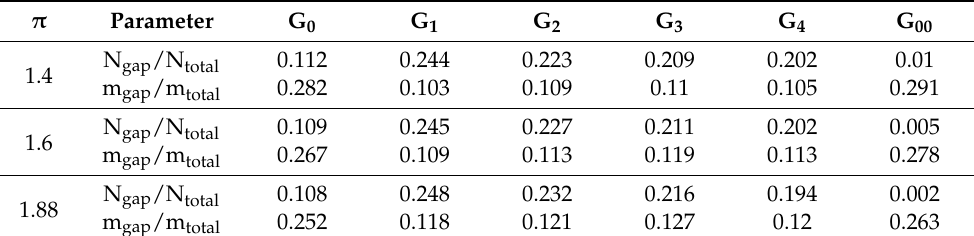
Table 1. Power and mass flow rate for individual gaps for 10,000